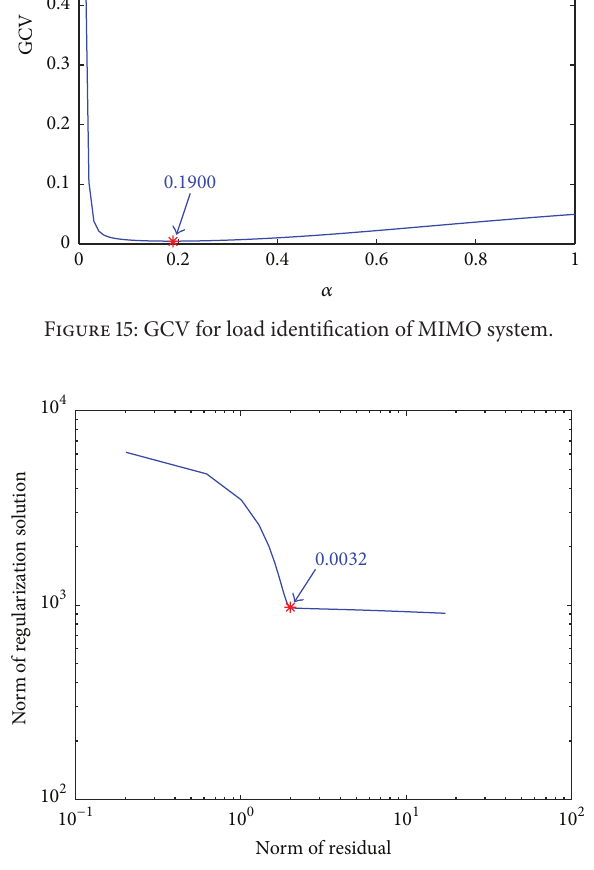
Figure 16: L -curve for load identification of MIMO